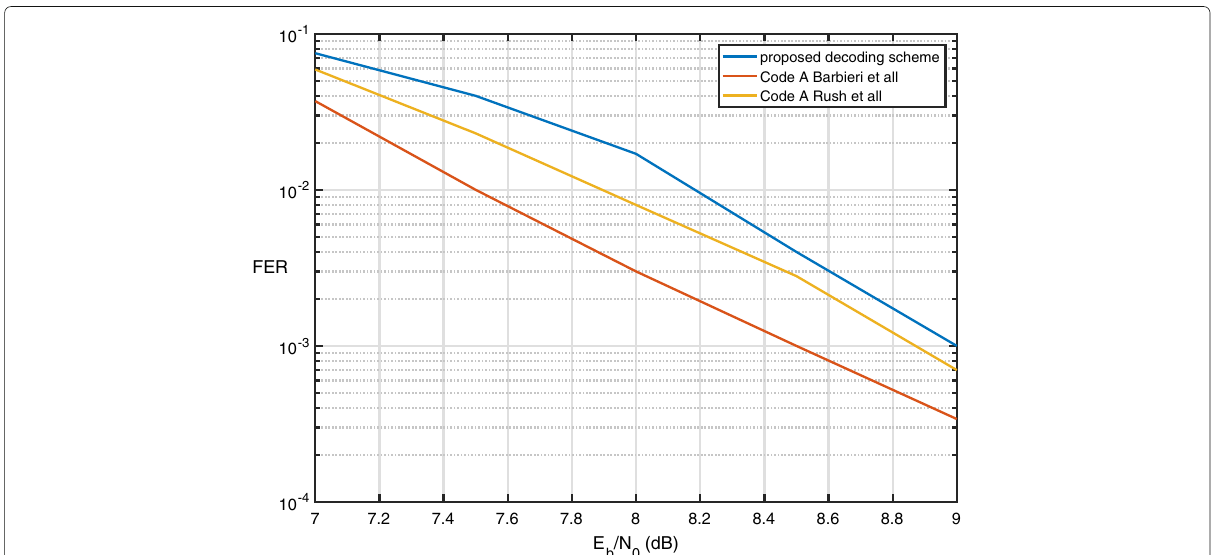
Fig. 4 FER versus E b comparison between the proposed scheme and two examples of SC decoded by the AMP algorithm. The code rate is 0.5 for all N 0 the three schemes